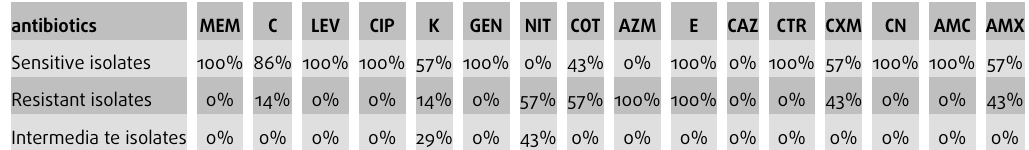
T(cid:724)(cid:725)(cid:735)(cid:728) 1: Susceptibility test of P. mirabilis isolates using disc diffusion